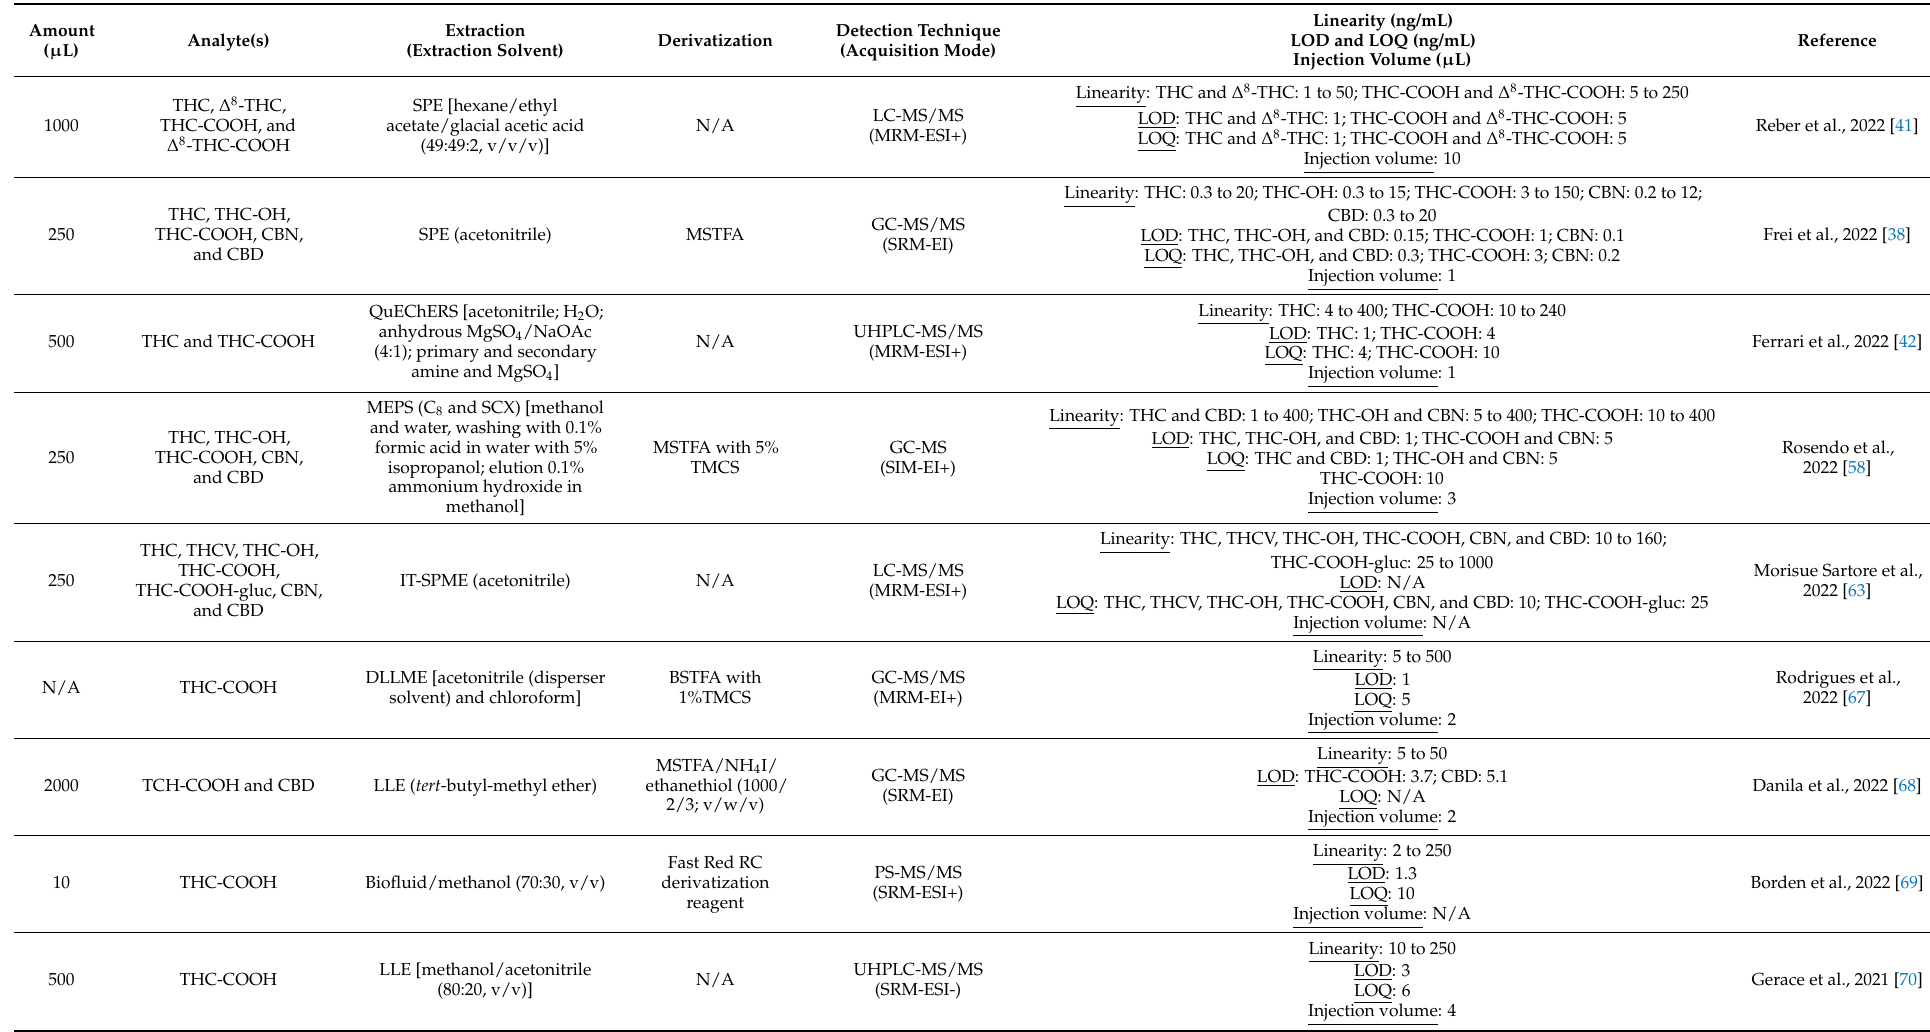
Table 3. Methods for the identification and quantification of cannabinoids in